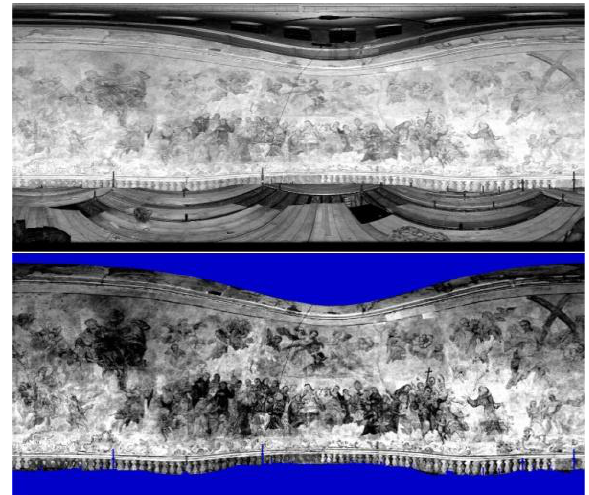
Figure 2 : Spherical image of the dome before filtration (top image) and after filtration (bottom image).